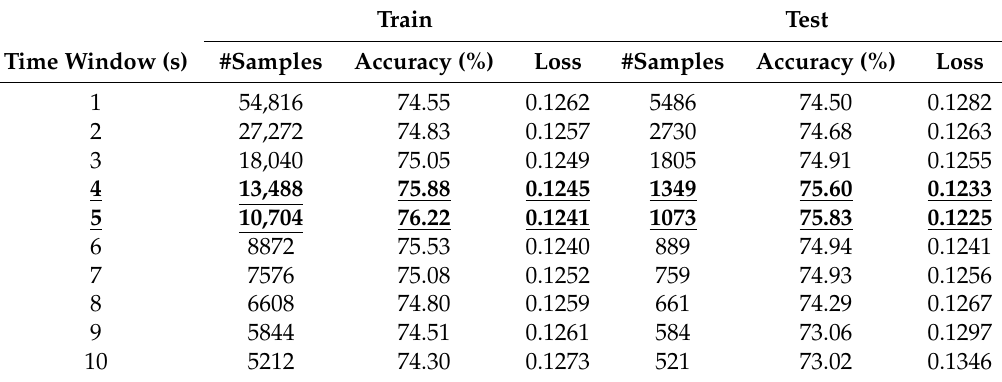
Table 3. Results obtained with GSR network classifying Valence (best time windows are marked). Train Test Time Window (s)